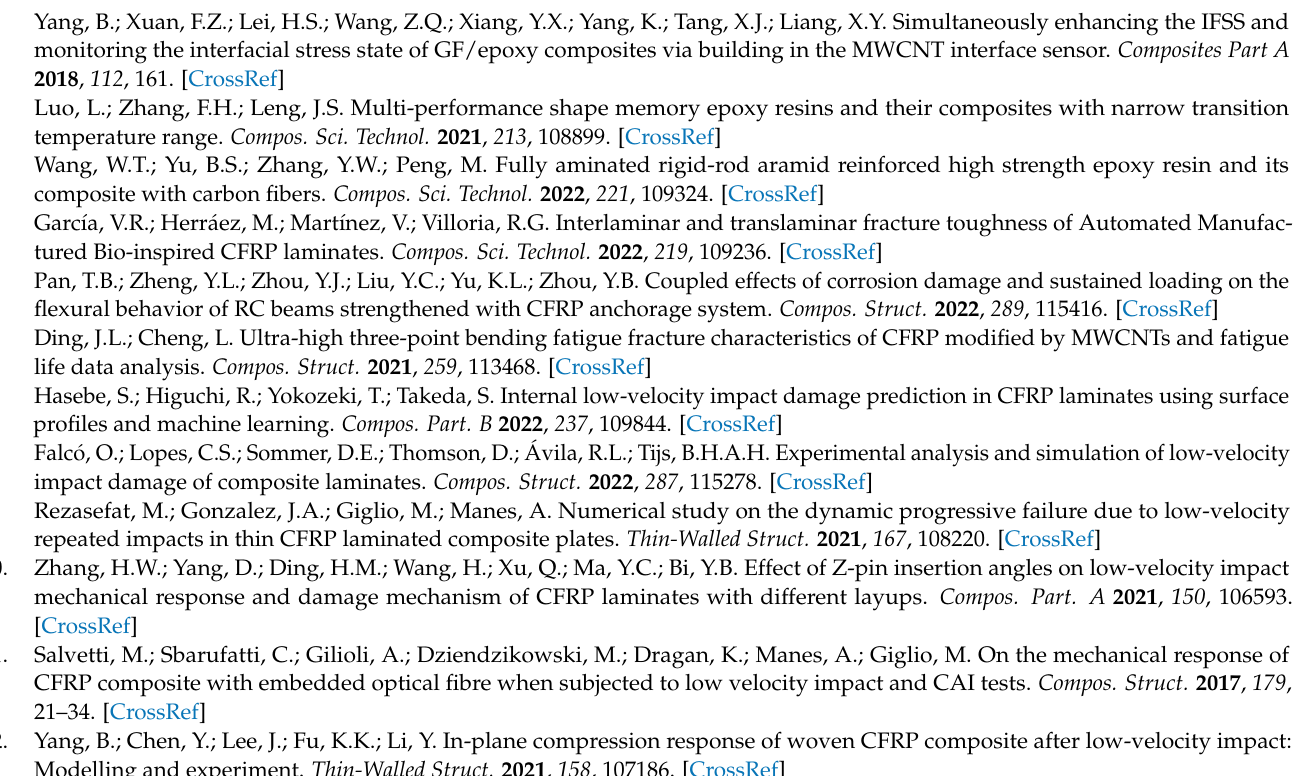
various thicknesses; Figure S4: CT images of the delamination area and depth; Figure S5. ( a ) Burning CF yarns at T = 870 ◦ C for 4 min. ( b )The burned fiber in ( a ) was used to carry out the tensile testing. ( c ) Setup image for CAI test; Figure S6: ( a ) Photos of a single CF yarn before and after the burning process, ( b ) Photos of the laminate after the burning process; Figure S7: Center temperature vs. heating duration at various powers; Figure S8: Typical load–displacement curve of panels with different thicknesses; Figure S9: SEM images of the repaired region after the thermal ablation process; Table S1: The average fiber volume fractions of CF/epoxy panels before and after repair; Table S2: Elemental composition analysis of CF surface before and after burning; Table S3: The suitable power adopted to heat the panels with various